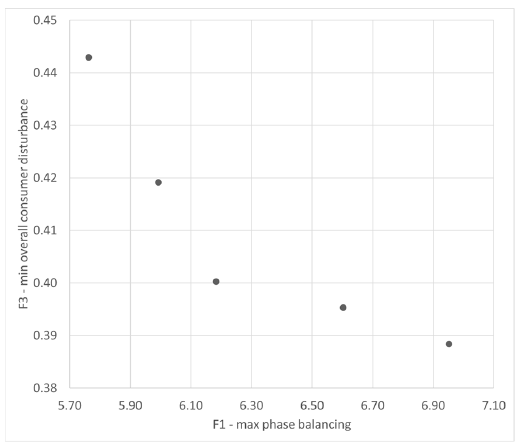
Figure 6. The Pareto frontier for the pair F1–F3.